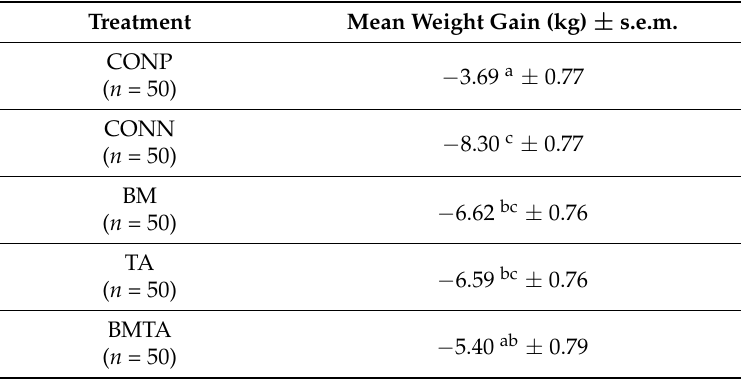
Table 2. Mean weight gain of calves in each treatment group over 6